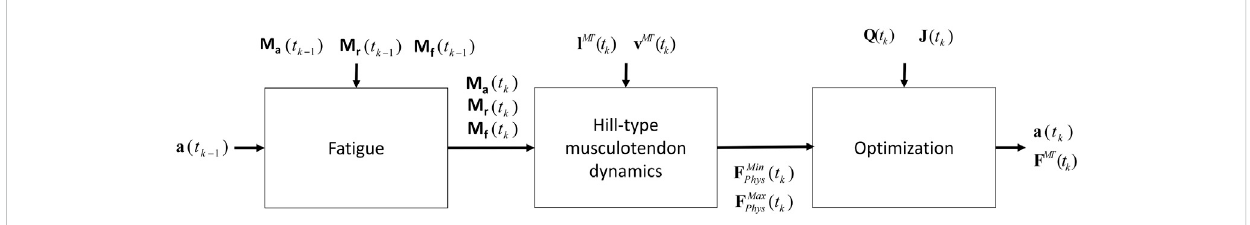
FIGURE 5 Procedure proposed that combines the physiological inverse-dynamics approach (used to address the muscle redundancy problem) with the muscle fatigue model, to determine individual muscle forces at time instant t k .